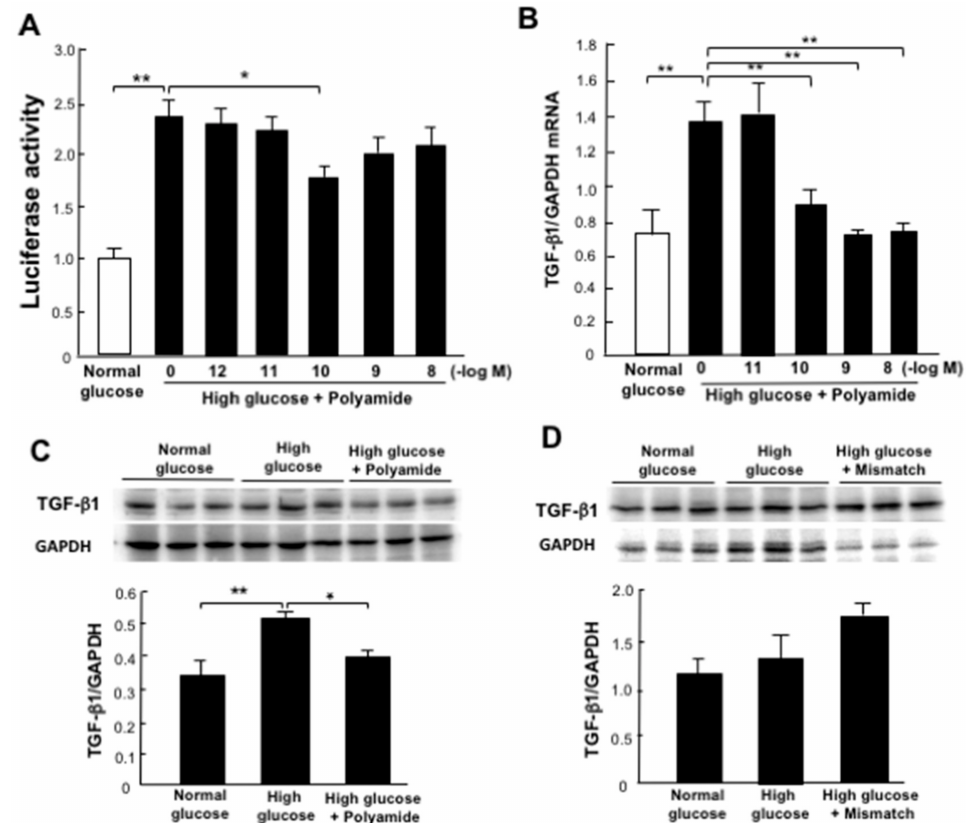
Figure 3. Effects of upstream stimulatory factor 1 (USF1) pyrrole-imidazole (PI) polyamide on transforming growth factor (TGF)- β 1 promoter activity and the expression of TGF- β 1 with high- glucose stimulation. ( A ) Effects of USF1 PI polyamide on TGF- β 1 promoter activity measured by double luciferase activity in HEK293 cells with high-glucose stimulation ( n = 4). ( B ) Effects of USF1 PI polyamide on the expression of TGF- β 1 mRNA in mesangial cells (MCs) with high-glucose stimulation by real-time analysis ( n = 6). Effects of ( C ) USF1 PI polyamide or ( D ) mismatch polyamide on the expression of TGF- β 1 protein in MCs with high-glucose stimulation by Western blot analysis ( n = 3). Data are the mean ± SEM. * p < 0.05, ** p < 0.01 between indicated